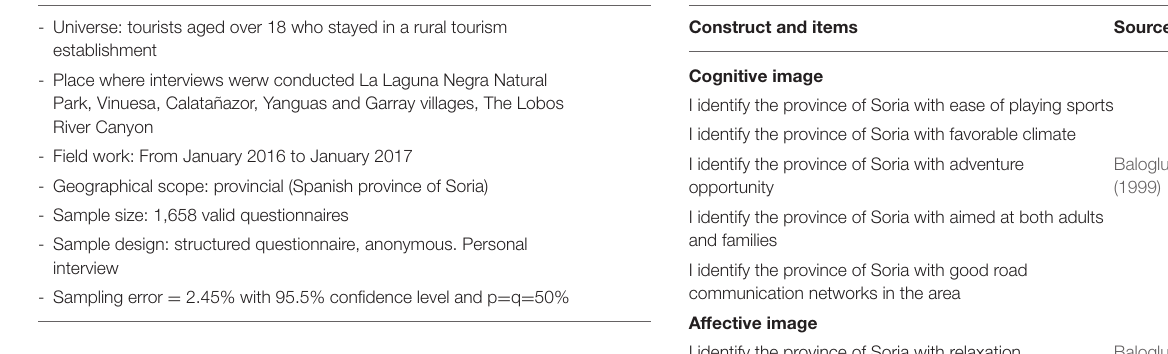
TABLE 1 | Technical details of the study. TABLE 2 | Scales of the model’s constructors.